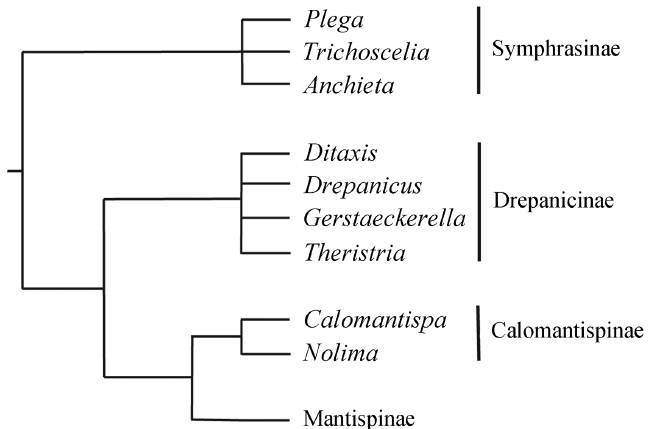
Figure 2. Phylogenetic relationships among subfamilies in Mantispidae (modified from Lambkin 1986a).